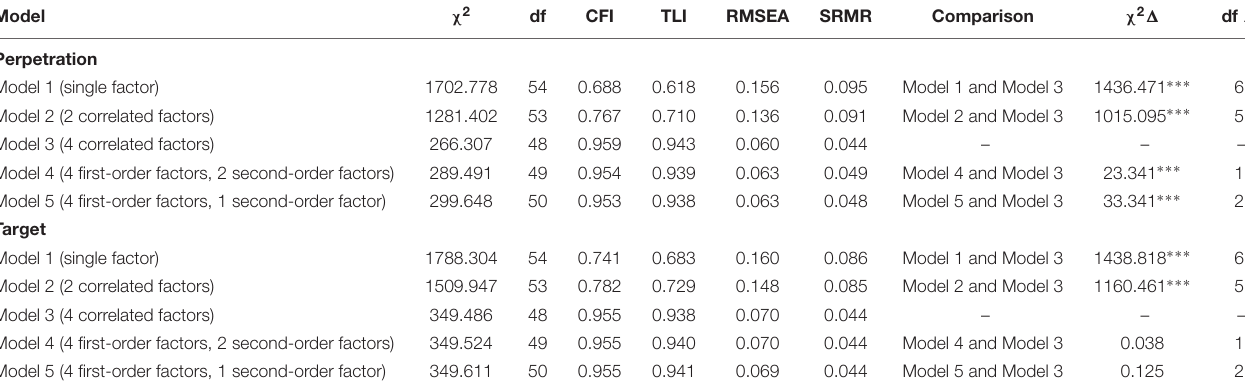
TABLE 1 | Study 1 Chi-square difference tests for perpetration and target versions of the DIRRS.